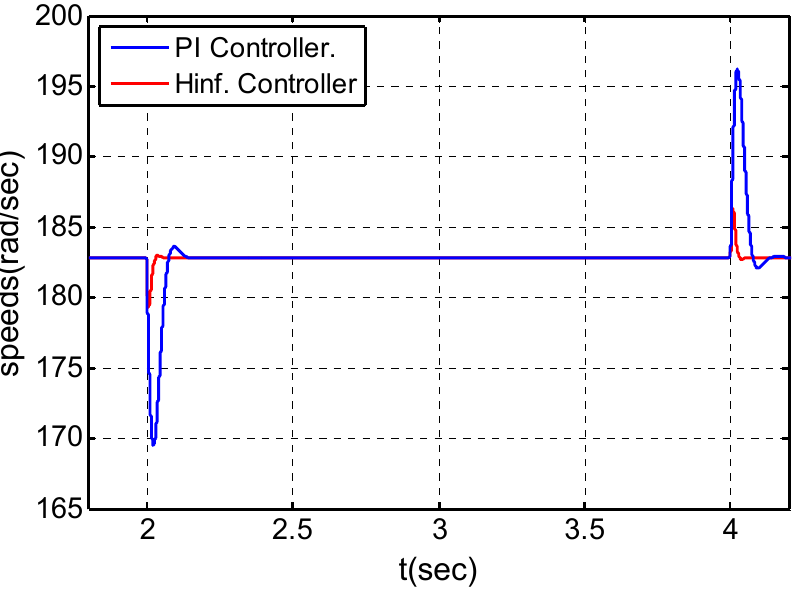
Figure 10. Response of the H ∞ controller versus the PI controller.